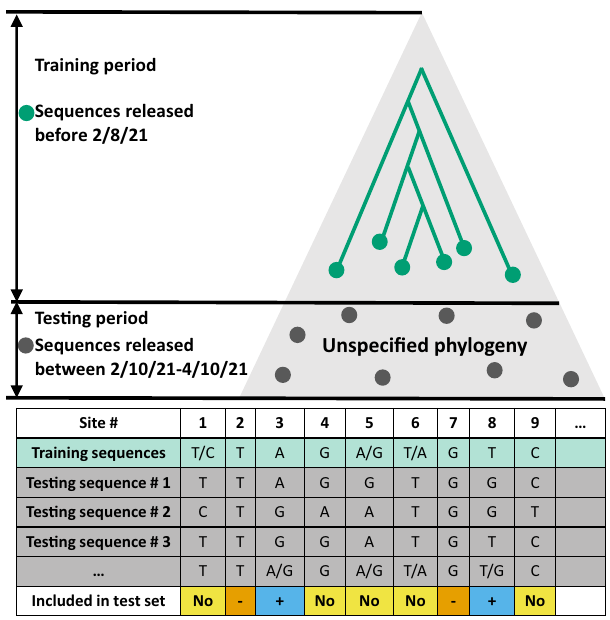
Fig. 2 An illustration of the training and testing dataset for prediction. Our training data consists of a phylogenetic tree reconstruction based on sequences released before February 8th, 2021 (green dots). The test data is comprised of sequences that were released between February 10th and April 10th, 2021 (gray dots). For these, we did not infer a phylogeny or rely on any other phylogenetic information. To evaluate our ability to predict new substitutions, we considered only sites for which no substitutions had occurred in the training data. The table in the fi gure shows examples of which substitutions are included in the test dataset. For sites 1, 5, and 6, the base is not constant for the training data set, and therefore it is not included in the test dataset. In sites 4 and 9, there is only one sequence in the test set that shows a different base from the training sequences; these sites have not been included in the test set to avoid sequencing errors. For sites 2 and 7, the base is constant for both the training and the test dataset making them negative examples in the test dataset, whereas sites 3 and 8 are positive examples, where a con fi rmed substitution occurred in the test